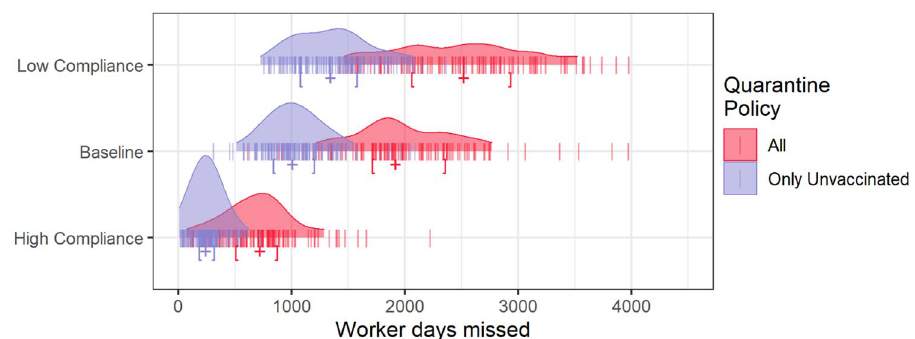
Figure 6. The distribution of worker days missed by scenario. The red denotes all workdays missed by vaccinated and unvaccinated firefighters while the blue denotes workdays missed by only unvaccinated firefighters. The Only Unvaccinated indication captures guidance current at the time. Brackets indicate the interquartile range and plus signs indicate the median value for each